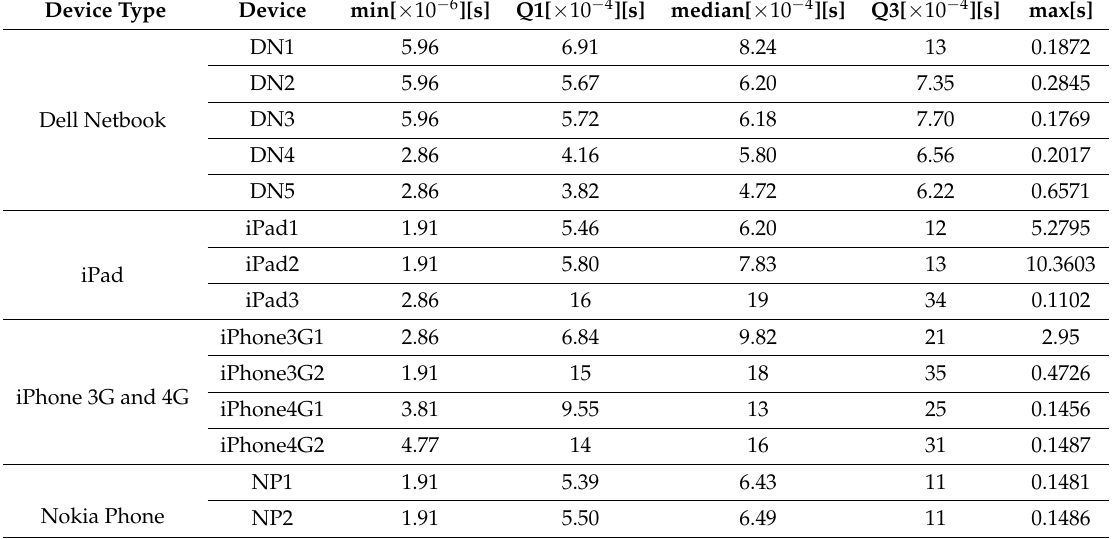
Table 4. 5 number summary of the TCP inter-arrival times (IAT)